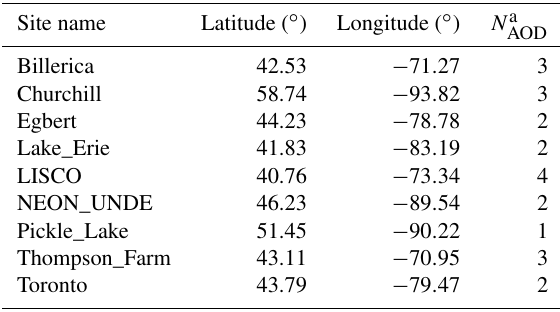
Table 3. AERONET sites selected for AOD